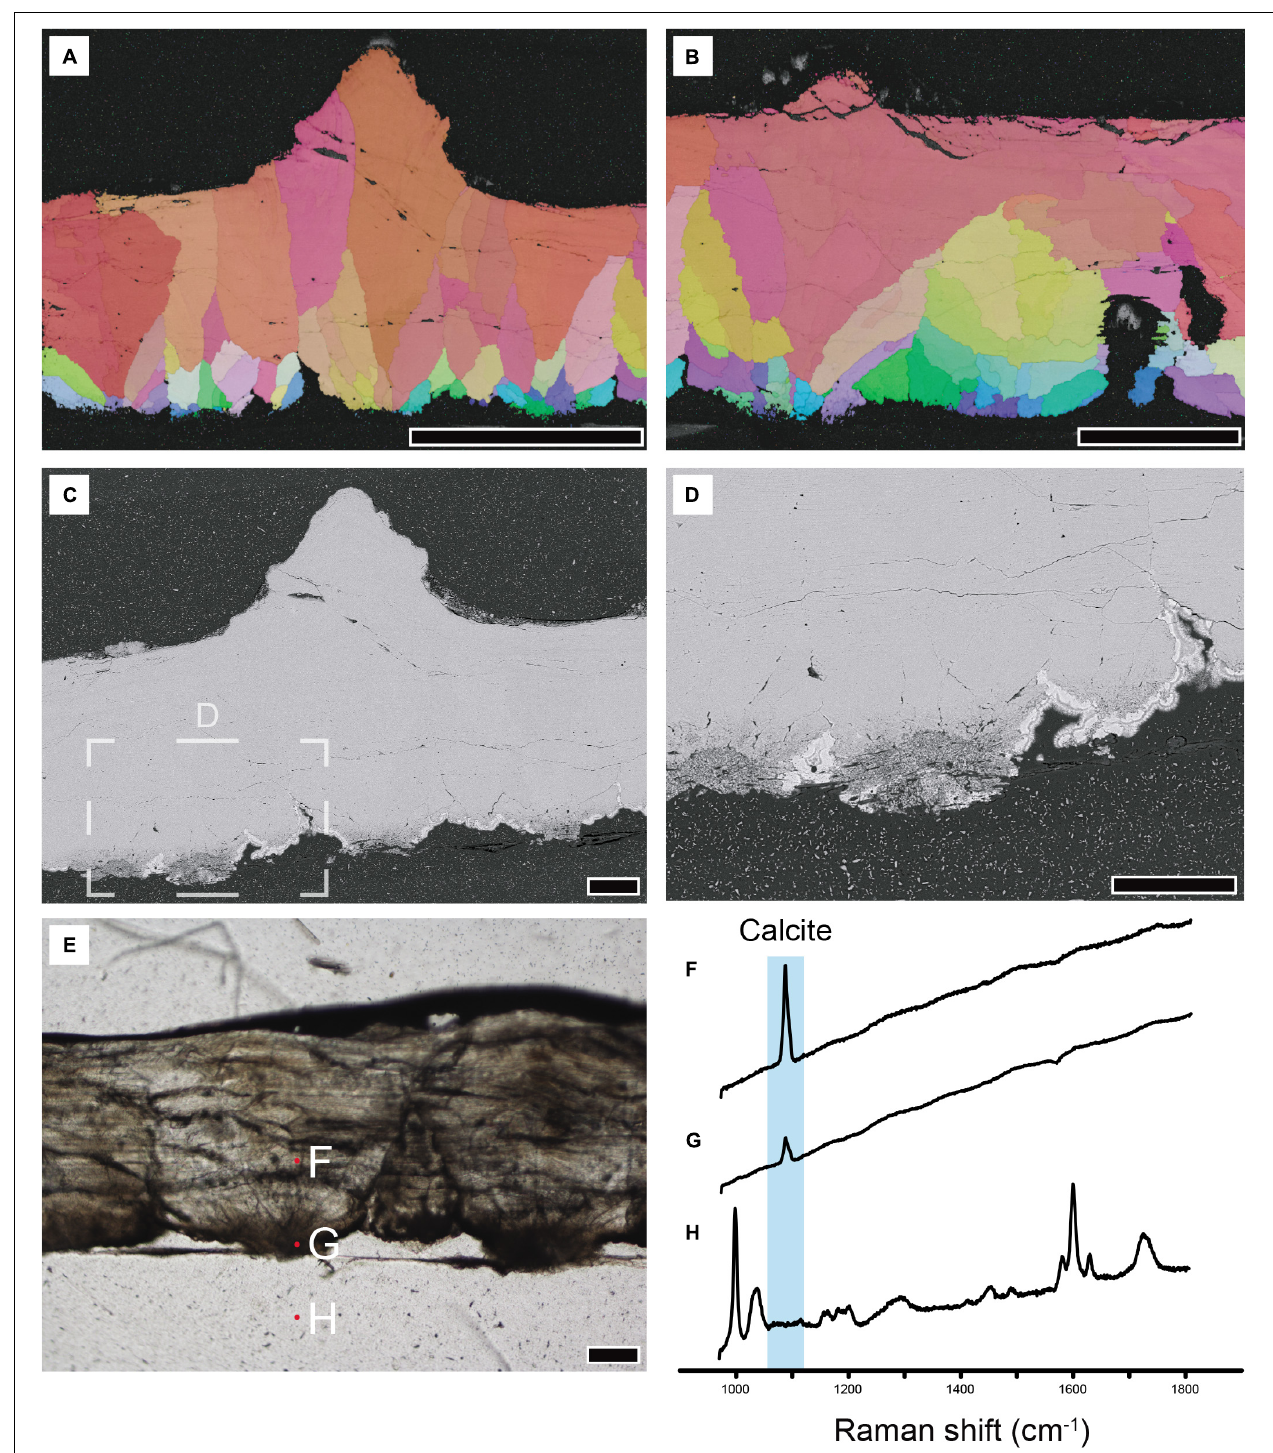
FIGURE 10 | Modern crocodylian ( Caiman latirostris ; UHR33185) eggshell analyzed with selected methods. (A,B) IPF maps. Note wedge-like calcite grains of crocodylian eggshell. Grains with horizontal c -axis is present toward the middle of the eggshell. (C,D) BSE imaging. Note that the inner end of the eggshell is composed of porous calcite. (E) Thin section imaging and locations where Raman spectra were acquired. Note that the inner dark band corresponds to the porous calcite figured in (D) above. (F–H) Raman spectra acquired at the locations marked in (E) . (F,G) In plain calcite and a dark part at the inner end of the eggshell, only calcite Raman peak is detected. Note the absence of amorphous carbon peaks (i.e., G,D bands) in (G) . (H) A spectrum from epoxy resin shows the peaks attributable to polyester resin and silica gel. Scale bars equal 500 µ m (A) ; 250 µ m (B) ; 100 µ m (C–E) .